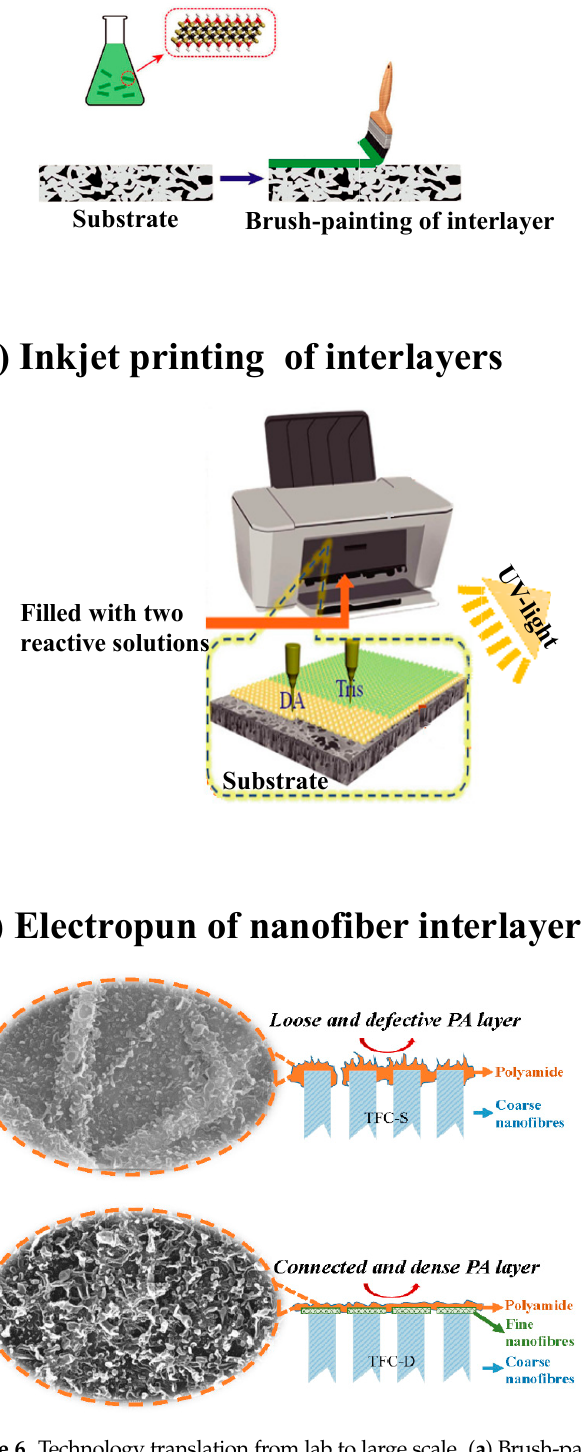
Figure 6. Technology translation from lab to large scale. ( a ) Brush-painting of Mxene on nylon membrane; ( b ) inkjet printing of dopamine and tris solution on UF membrane for mass production; ( c ) Construction of ultrafine nanofiber interlayer via electrospinning. All figures were taken from the references.